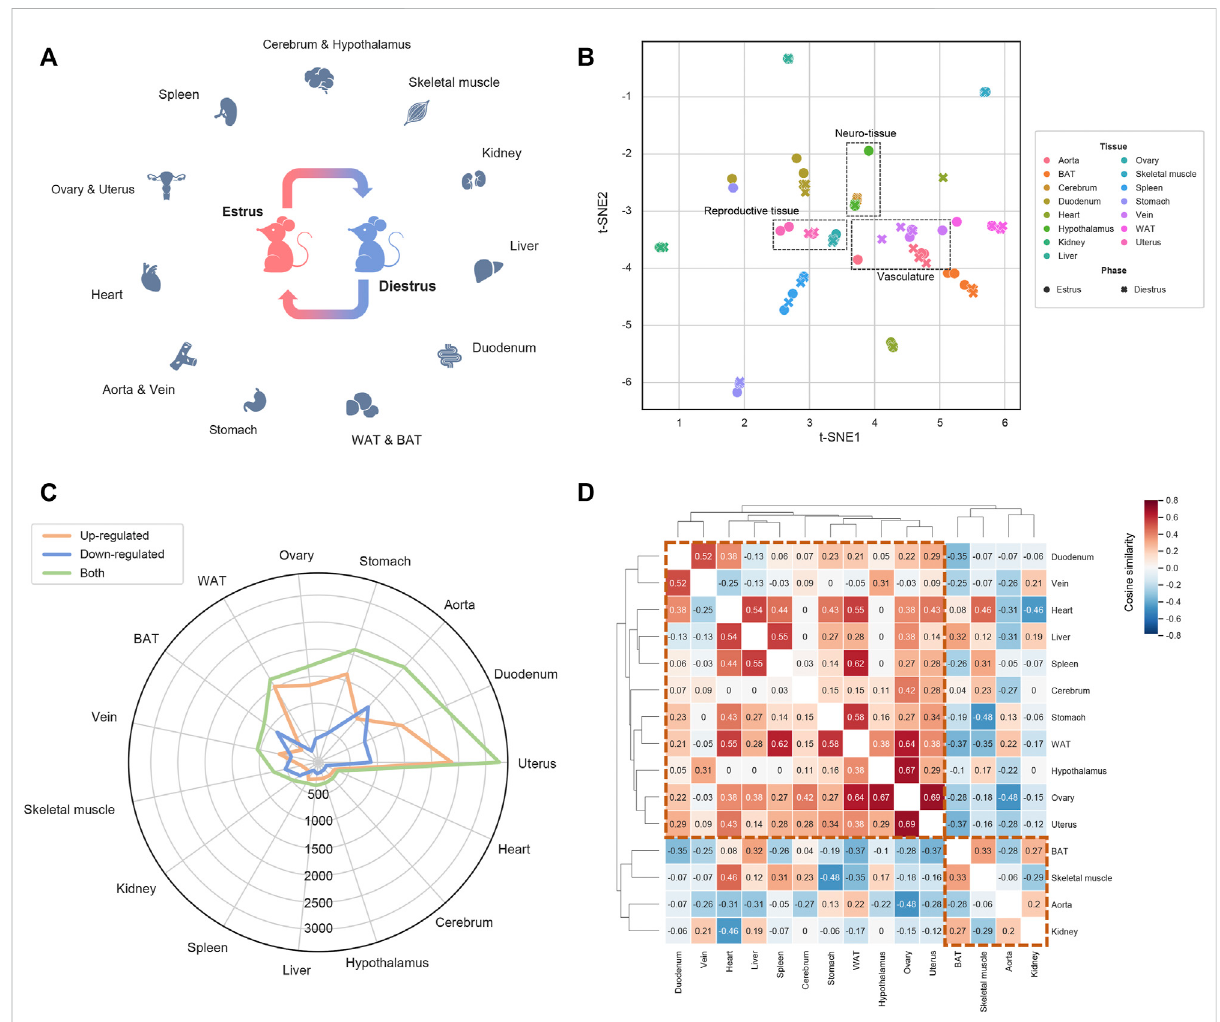
FIGURE 1 Overview of the transcriptomic landscape under estrous cycle (A) The transcriptomic landscape covering 15 tissues dissected from the mice at the estrus phase and the diestrus phase. For each tissue-phase group three biological replicates were set, resulting in 90 samples in total (B) Sample visualization by t-SNE based transcriptomic dimensionality reduction (C) The DEG number ofeach tissue (D) The tissue clustering map based on the cosine similarity of the shared DEGs ’ alteration